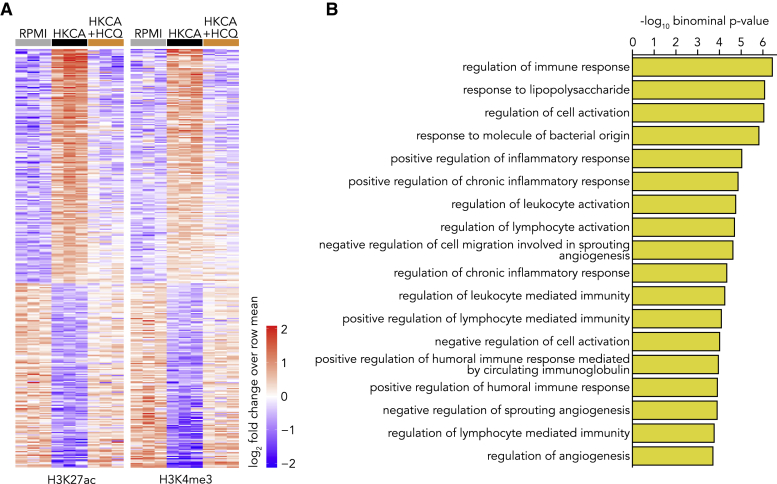
HCQ Prevents the Epigenetic Changes That Underly Trained Immunity(A and B) PBMCs were stimulated with HKCA, HKCA+HCQ, or RPMI as a control for 24 h, after which cells were rested for 5 days. Subsequently, monocytes were purified and ChIP was performed for H3K27ac and H3K4me3 (n = 3 per treatment group).(A) Heatmap showing relative H3K27ac (left panel) and H3K4me3 (middle panel) dynamics at sites with a significant change in histone mark abundance (FDR, <0.01) between HKCA-stimulated and control monocytes.(B) GO enrichment analysis of regulatory elements that remain epigenetically activated in HKCA-trained monocytes compared to HKCA+HCQ-treated cells (FDR, <0.01). Gene sets significantly associated at both an FDR Q value of <0.05 and a binominal p value of <0.05 are shown.